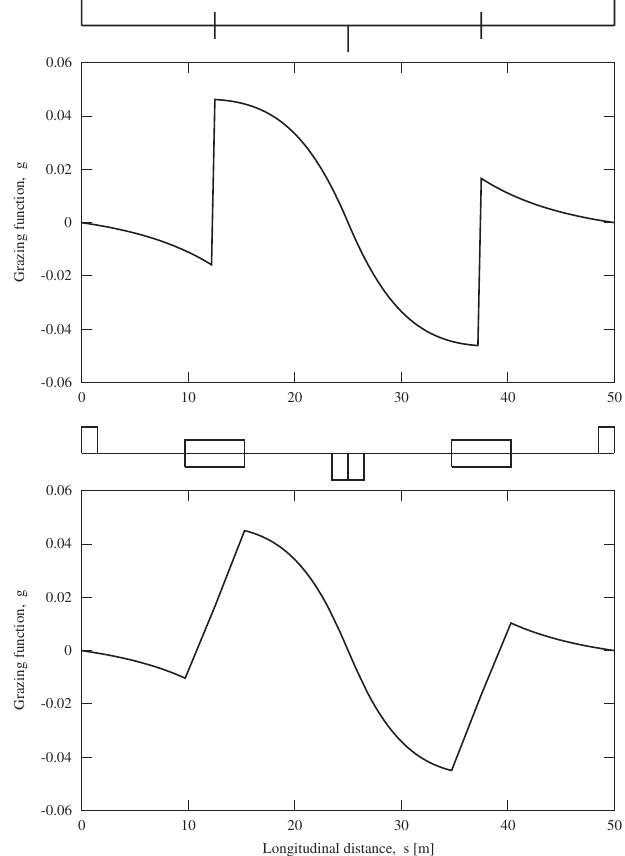
FIG. 1. The grazing function in a matched FODO cell with thin quads and dipoles (top), and partially filled with short quads and dipoles (bottom). In both cases the half cell is L ¼ 25 m long, with a phase advance of 90 degrees per full cell in both planes, and with a bend angle of (cid:8) ¼ (cid:5)= 50 radians per half